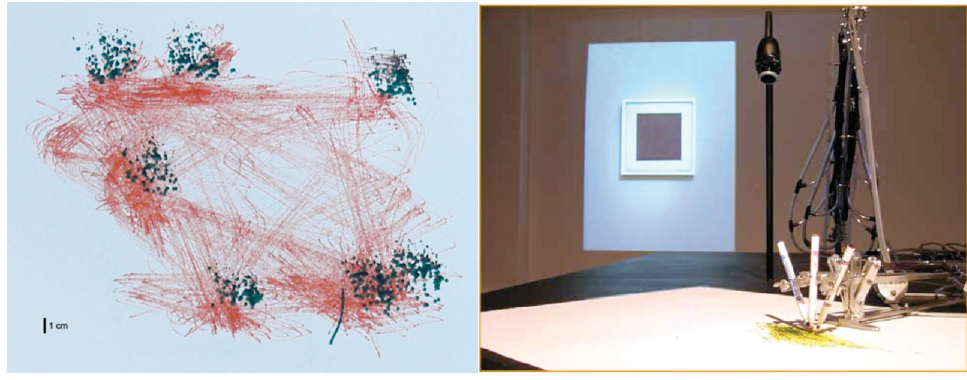
Figure 6. Accuracy test of the robotic drawing machine . Movements between seven locations were commanded 200 times in random order. A dark pen marked the target locations, while an offset lighter colored pen traced the movement trajectory. 3cm × 3cm resolution targets could be reached within 4second and a 1cm × 1cm target around 10second (not shown). A photograph of Malevich’s “Black Square” painting can be seen projected on the gallery wall. arms out of view and capturing an image, analogous to a painter stepping back from the canvas to check the work in